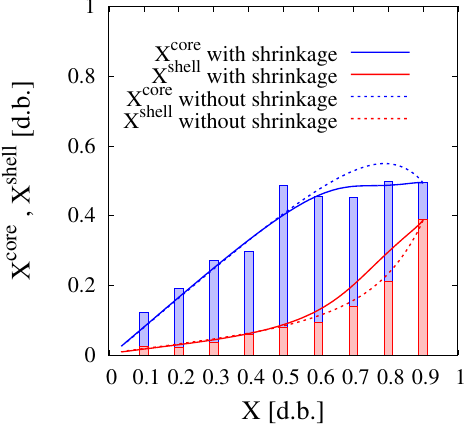
Figure 13. Moisture content in the core X core and in the shell X shell vs. the total moisture content X = X core + X shell (kg/kg db) for cocoa beans of data set (2), T = 60 ◦ C and v = 0.6 m/s. Comparison between experimental data (vertical bars) and model predictions (continuous and dashed lines) with D = 3.12 × 10 − 10 m 2 /s, Bi m = 12.87. Continuous lines indicate model predictions with a constant shrinkage factor α 0 = 0.39. Dashed lines indicate model predictions without shrinkage α 0 = 0.